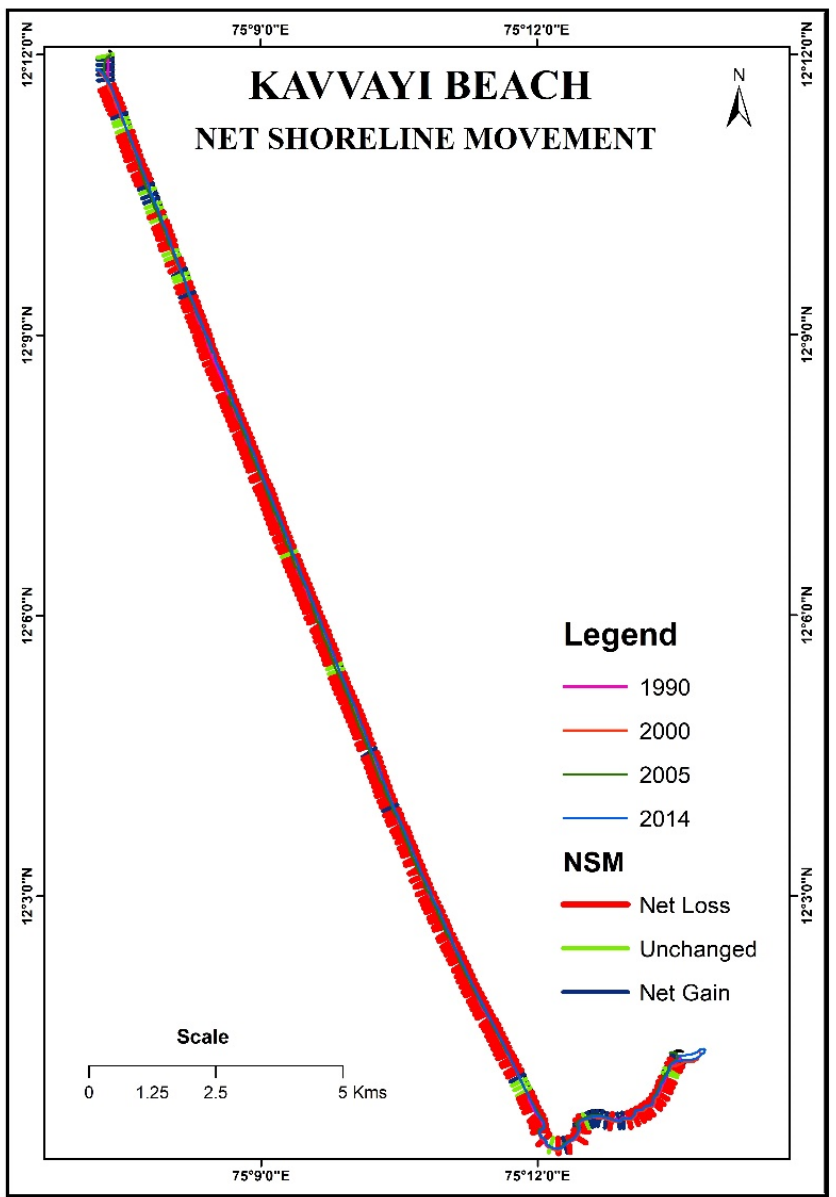
Figure 2. Net Shoreline Movement (NSM) of Kavvayi beach throughout the period of study from 1990 to 2014.